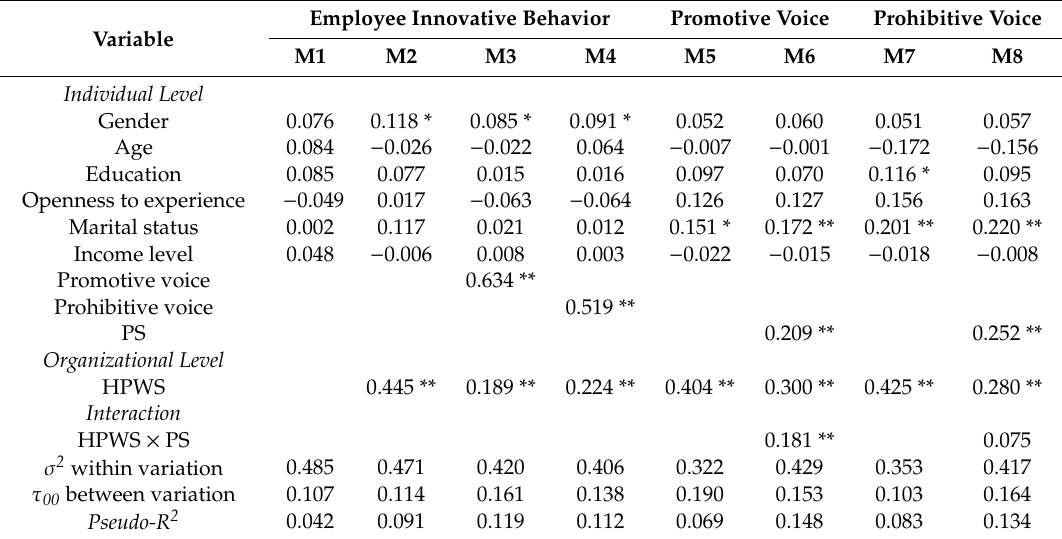
Table 3. The test result of the hypothesis 1 to 5